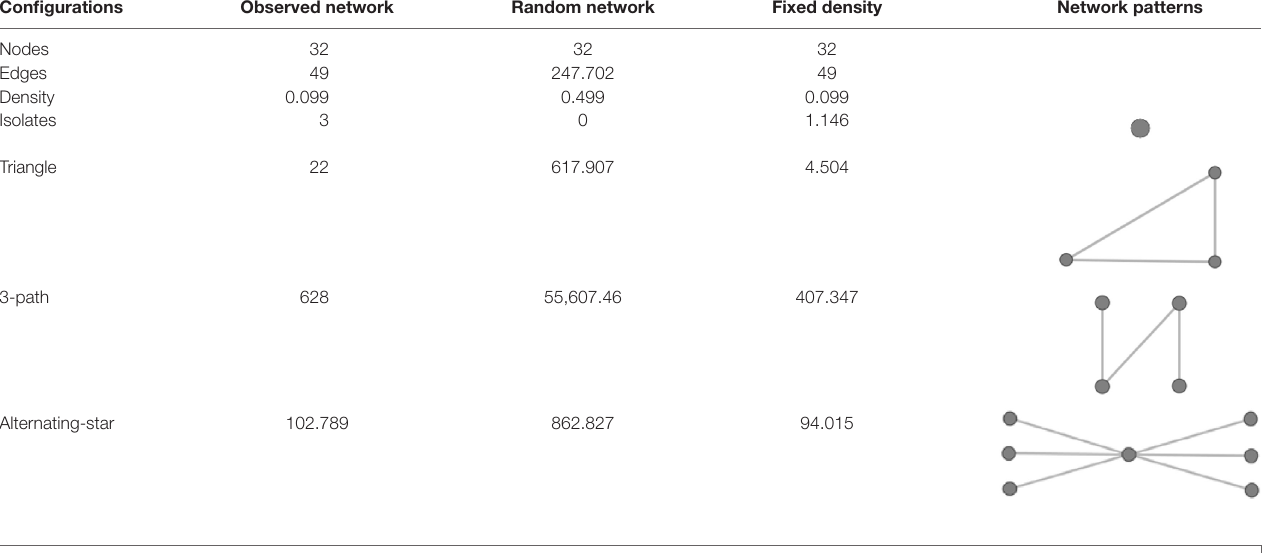
TaBle 5 | Network measures and count of visibility network configurations in the subnetwork at the center of the Cranborne Chase study area shown in Figure 11 above.